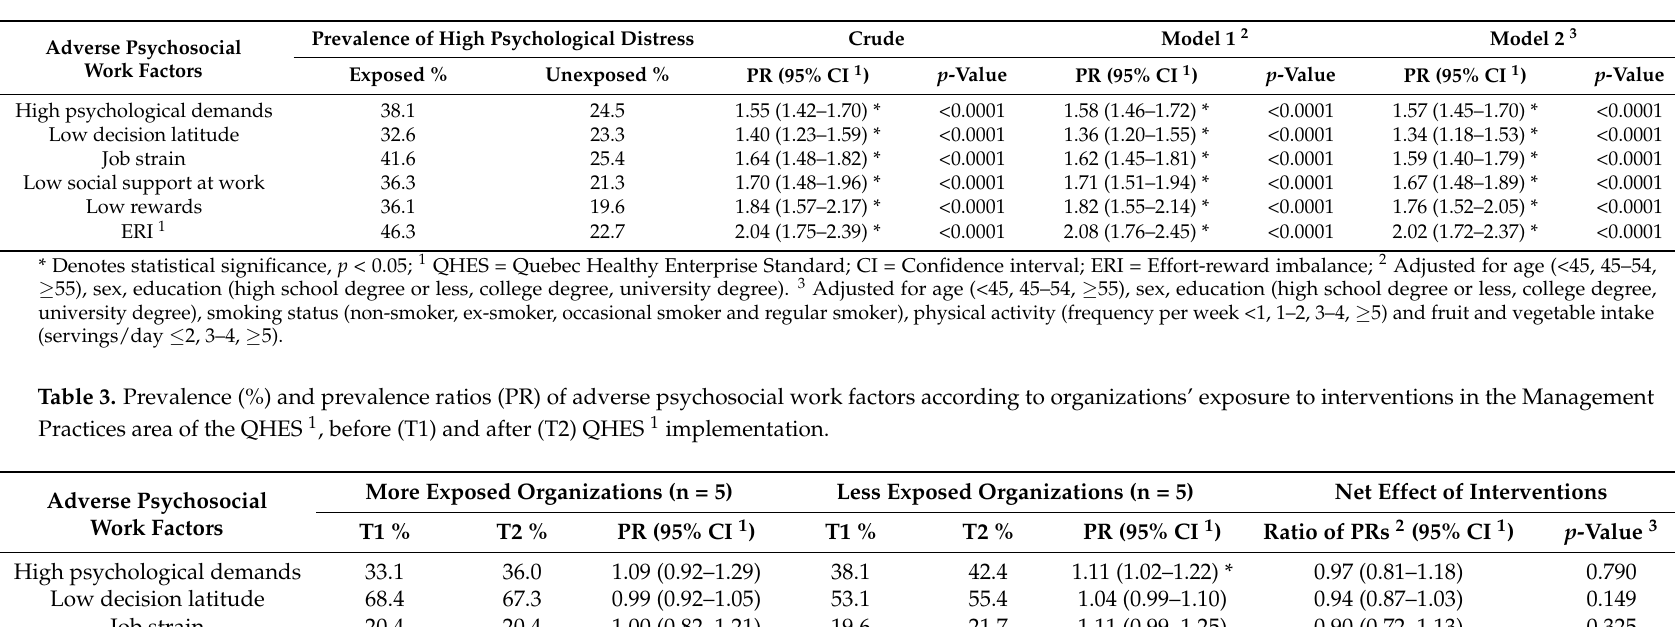
Table 2. Prevalence (%) and prevalence ratios (PR) of high psychological distress according to exposure to adverse psychosocial work factors among the 2849 participants before (T1) QHES 1 implementation.